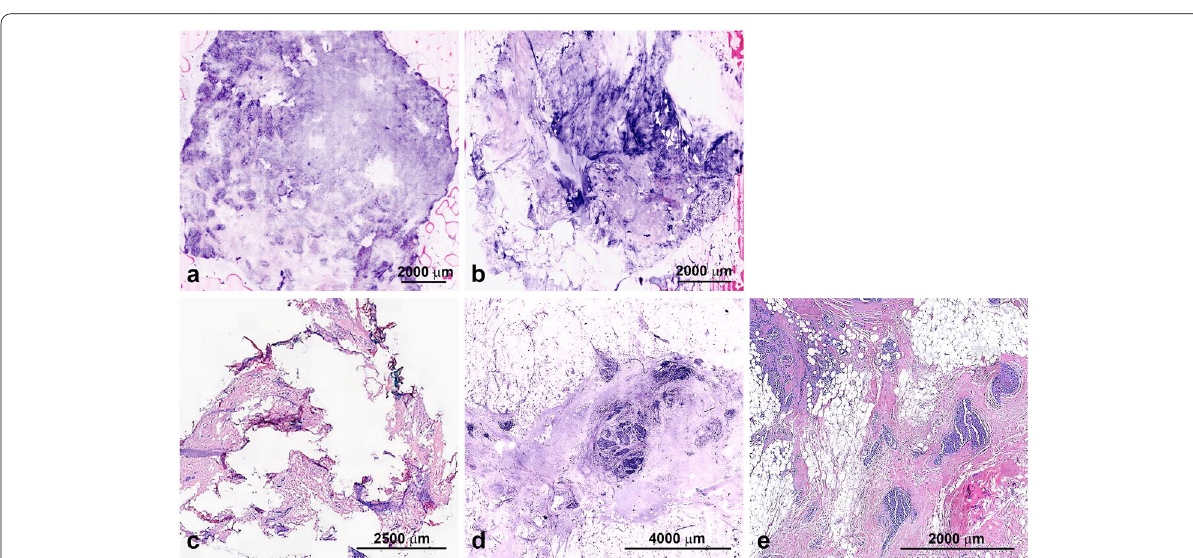
Fig. 2 A Uneven staining, B Mechanical pressure too high in certain areas (middle) and too low in upper right hand corner, C Frozen Section of tumor area, D Vivascan 2500M-G4 image of tumor area from same case, E Traditional HE staining of tumor area from same